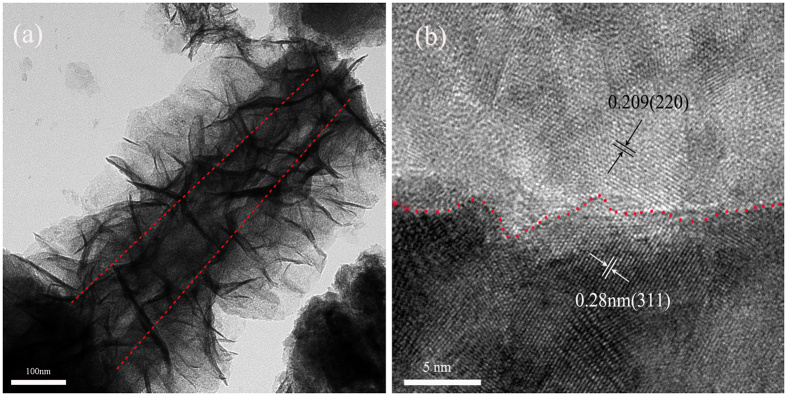
(a) TEM image of the NiCo2S4@NiO core-shell nanowire. (b) HRTEM image of the NiCo2S4@NiO core-shell nanowire.